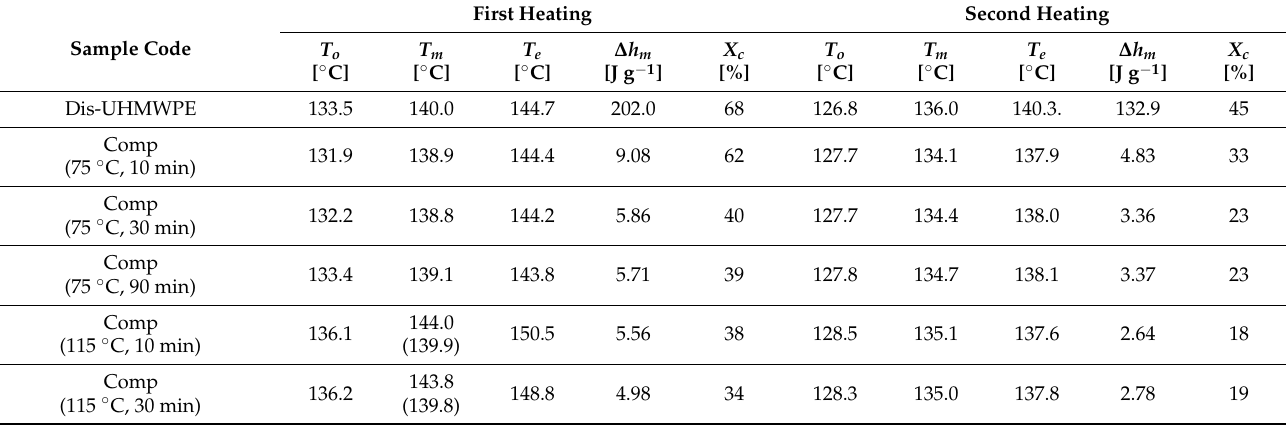
Figure 5. DSC curves obtained at 10 °C min − 1 during the first ( a ) and second ( b ) heating of EOC, and EOC/UHMWPE nanocomposites. The melting endotherm of dis-UHMWPE is separately presented ( c ) for clarity. Table 1 compares T m , melting onset ( T o ), and endset ( T e ) temperatures and the degree of crystallinity ( X c ) calculated based on the first and second heating thermograms. Table 1. Calorimetric data of dis-UHMWPE powder and EOC/UHMWPE nanocomposites processed at different conditions. T m , T o , and T e denote the melting peak temperature, the onset, and endset melting temperatures, respectively, whereas Δ H m and X c are the melting enthalpy, and the degree of crystallinity of dis-UHMWPE calculated based on its melting enthalpy according to Equation (2), respectively.